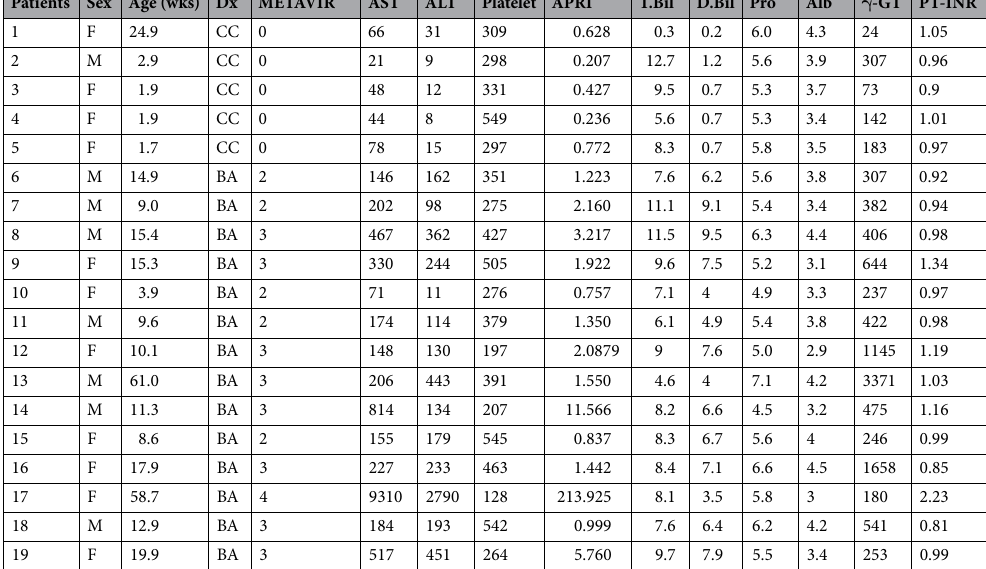
Table 2. The histological and clinical characteristics of all patients with cholangiopathy. Age (wks) = age at the time of liver wedge biopsy (weeks); Dx = Diagnosis; AST = aspartate aminotransferase (IU/L); ALT = alanine aminotransferase (IU/L); APRI = AST to platelet ratio index; T.Bil = total bilirubin (mg/dL); D.Bil = direct bilirubin (mg/dL); Pro = Protein (g/dL); Alb = Albumin (g/dL); γ -GT = gamma-glutamyl transpeptidase (IU/L); PT-INR = prothrombine time-international normalized